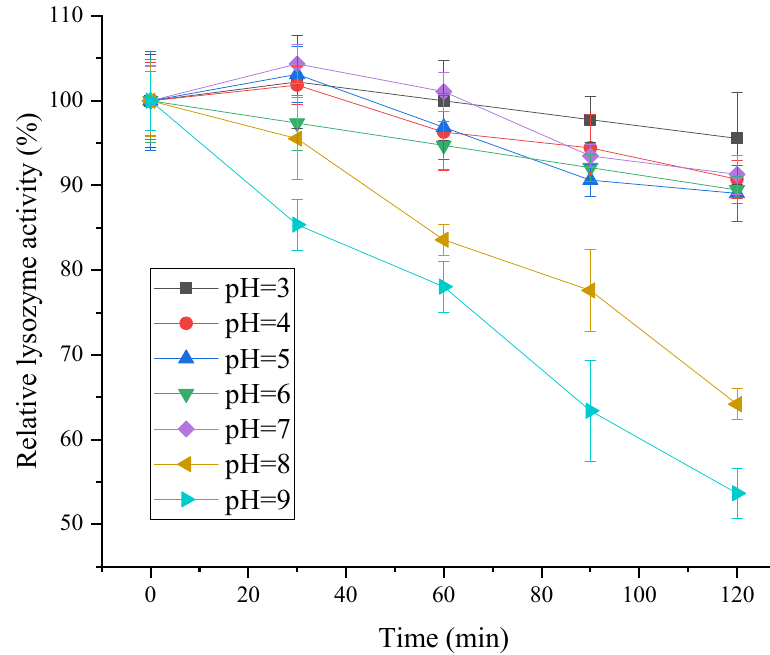
Figure 8. pH stability of lysozyme from SDEW.